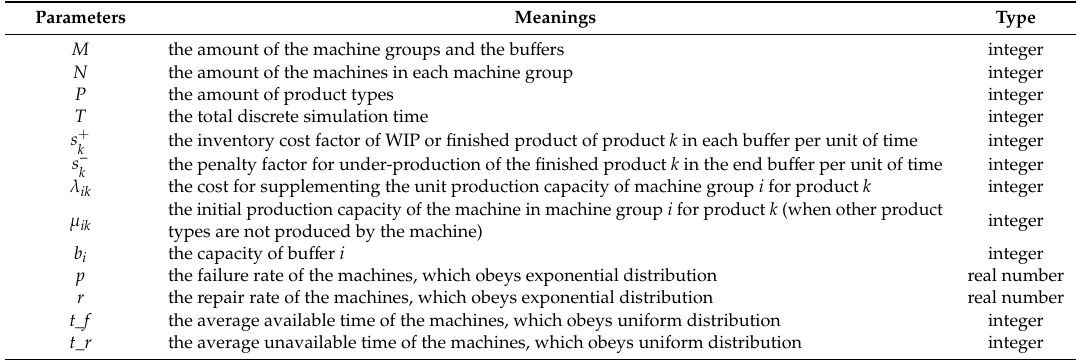
Table 1. The system parameters in the manufacturing system. WIP: work-in-process.